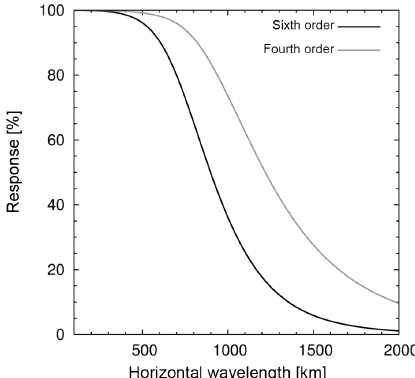
Figure 2. Amplitude response of the AIRS 15µm brightness tem- perature data set for gravity waves with different across-track wave- lengths. The plot shows the response using a fourth- or sixth-order polynomial fit to estimate background signals.